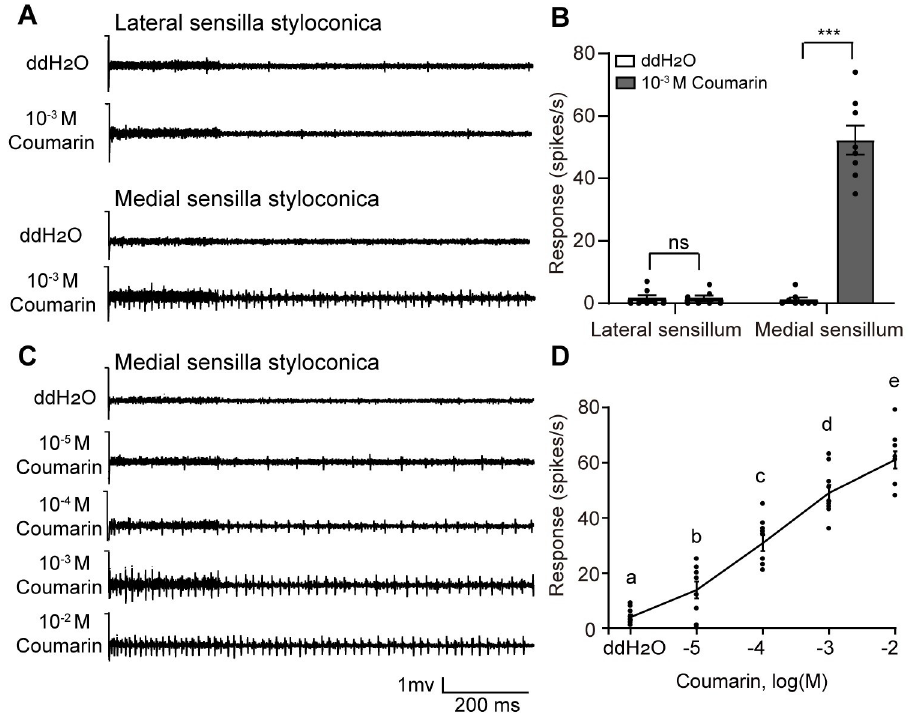
Fig 3. Electrophysiological response of sensilla styloconica on the maxillary galea of Helicoverpa armigera larvae to coumarin. ( A ) Representative responses and ( B ) spike frequencies of lateral and medial sensilla styloconica to coumarin and double distilled water (ddH 2 O) at 10 − 3 M (n = 8). ��� and ns indicate significant difference (p < 0.001) and no significant difference (p > 0.05), respectively (two-tailed independent samples t -test). ( C ) Representative responses of medial sensilla styloconica to coumarin at a series of concentrations. ( D ) Dose responses of medial sensilla styloconica to coumarin (n = 8–10). Different letters indicate significant difference (one-way ANOVA followed by post-hoc analysis with Tukey’s HSD test). Data are mean ±